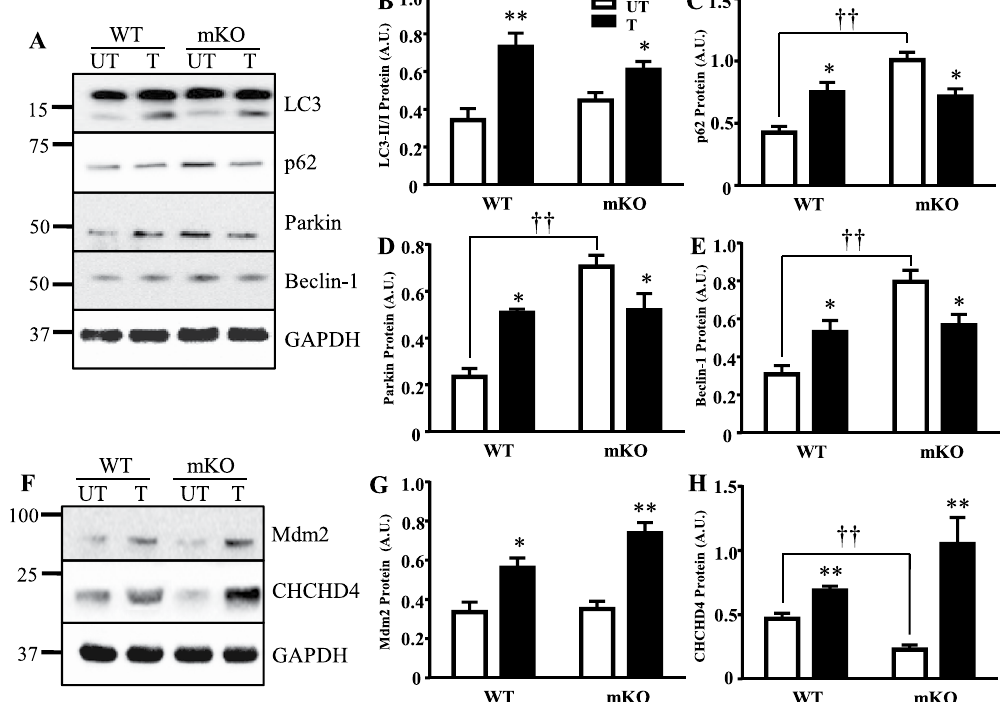
Figure 5. Autophagy protein response and regulators of p53 expression in the absence of p53 and with training. ( A ) Proteins in the autophagy pathway were measured; ( B ) LC3-II/LC3-I ratio (n = 6–8/group); * p ≤ 0.05, ** p ≤ 0.01, UT vs. T, 2-way ANOVA, ( C ) p62 (n = 5–8/group), * p ≤ 0.05, UT vs. T; †† p ≤ 0.01, UT WT vs. mKO, 2-way ANOVA, ( D ) Parkin (n = 5–7/group); * p ≤ 0.05, UT vs. T, Student’s t-test and 2-way ANOVA; †† p ≤ 0.01, UT WT vs. mKO, 2-way ANOVA, and ( E ) Beclin-1 (n = 5–7/group); * p ≤ 0.05, UT vs. T, Student’s t-test; †† p ≤ 0.01, UT WT vs. mKO, 2-way ANOVA. ( F ) Regulators of p53 expression (Mdm2) and its mitochondrial localization (CHCHD4) were next examined. Whole muscle protein expression of ( G ) Mdm2 (n = 5–6/ group); * p ≤ 0.05, ** p ≤ 0.01, UT vs. T, 2-way ANOVA, and ( H ) CHCHD4 (n = 5–6/group); ** p ≤ 0.01, UT vs. T, Student’s t-test and 2-way ANOVA; †† p ≤ 0.01, UT WT vs. mKO, Student’s t-test, was measured. Data are presented as mean ±